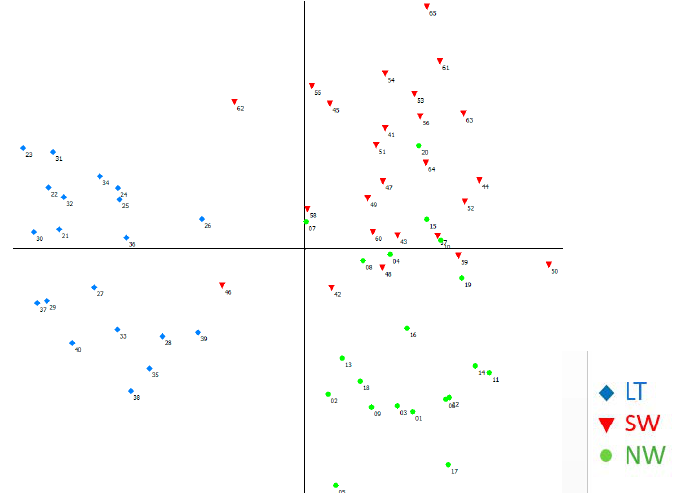
Figure 2. Principal coordinate analysis of all individuals from all sampling regions. Numbers represent individuals from the LT (blue diamonds), the SW (red triangles), and the NW (green dots) Regions. The first two axes explain about 25% of the genetic variations (axis one 16.80%, axis two 8.44%).